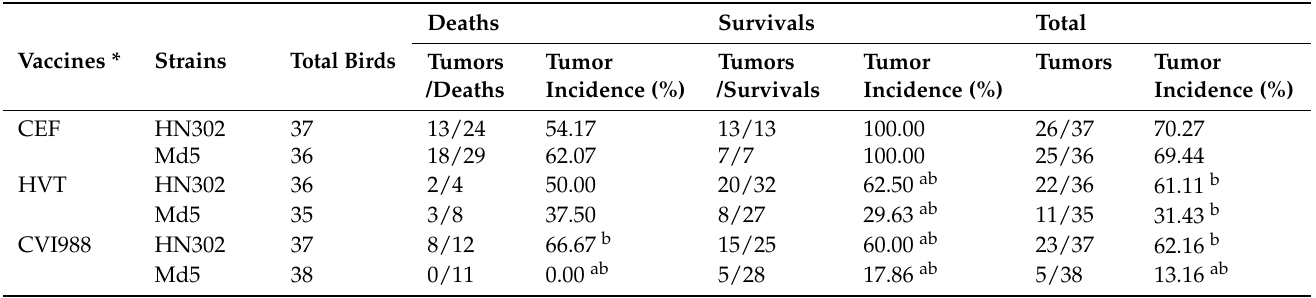
Table 4. Cumulative gross tumor incidence in vaccinated birds challenged by HNLC302 or Md5 strains calculated at 91 days post-infection (dpi).